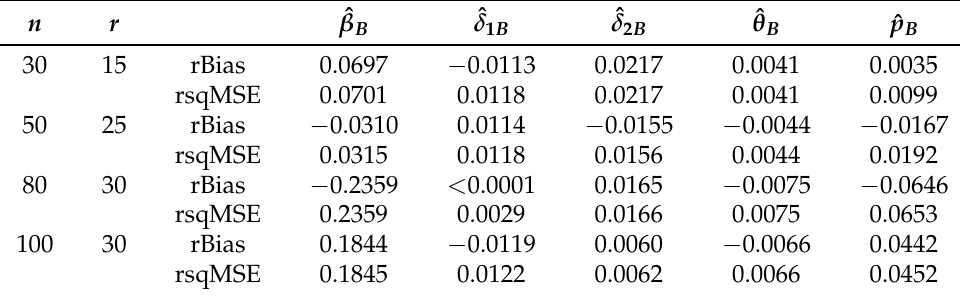
Table 5. The rBias and rsqMSE of Bayes estimates for p =